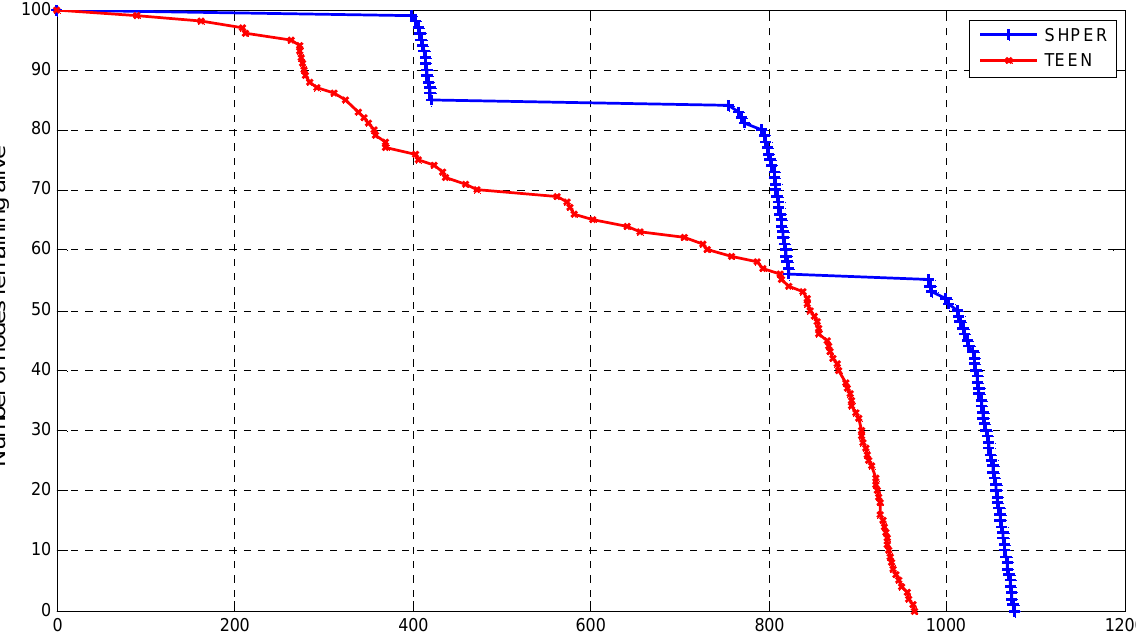
Figure 10. Comparative depiction of the nodes remaining alive over the simulation time steps in SHPER and TEEN [ Er (0)  [0.1,0.5] J, D = 100 i